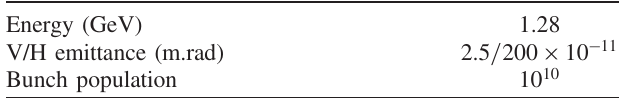
TABLE I. ATF2 beam parameters. Energy (GeV) 1.28 V/H emittance (m.rad)